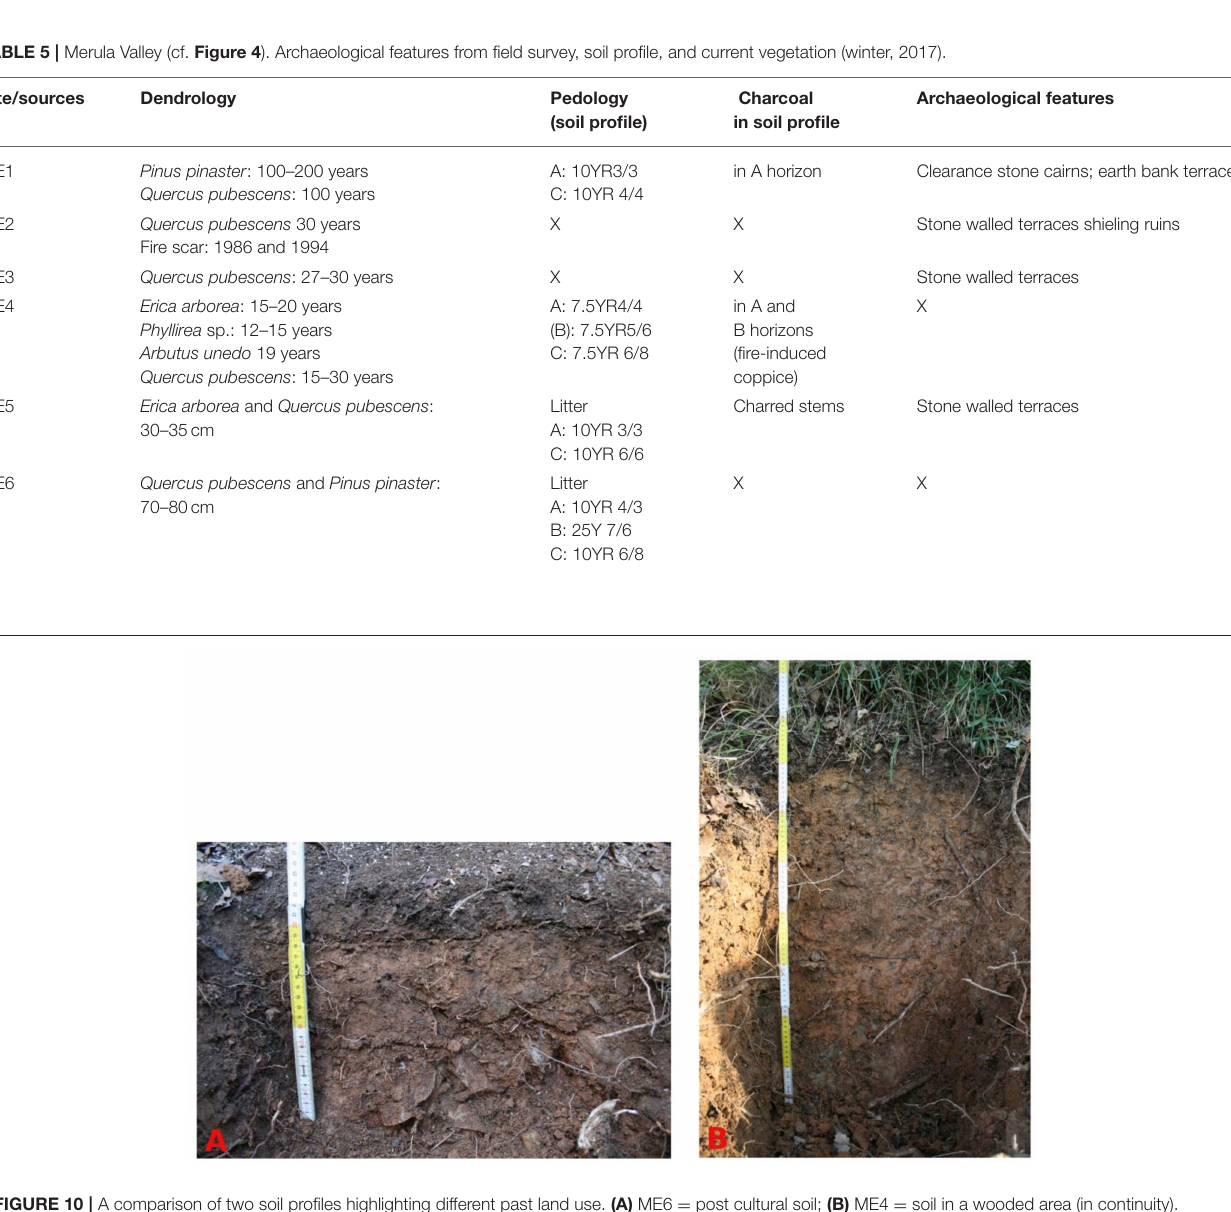
Frontiers in Environmental Science |